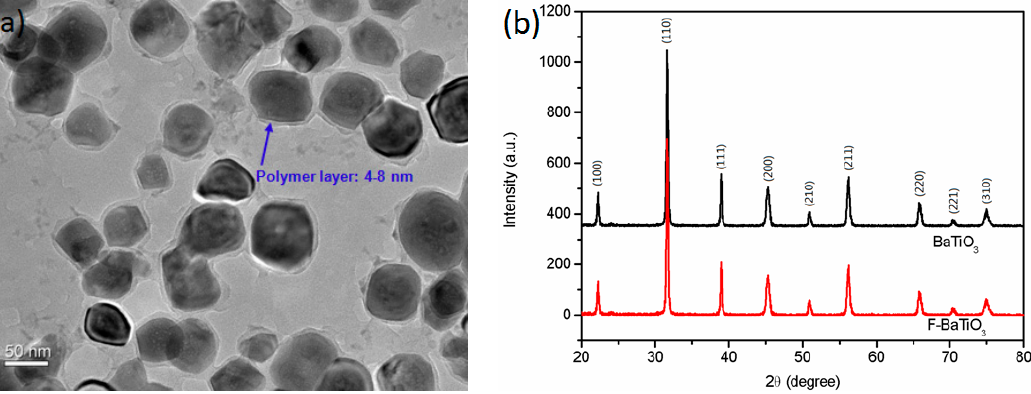
Figure 4. ( a ) TEM images of F-BaTiO 3 particles; and ( b ) XRD spectra of pristine BaTiO 3 and F-BaTiO 3 particles.